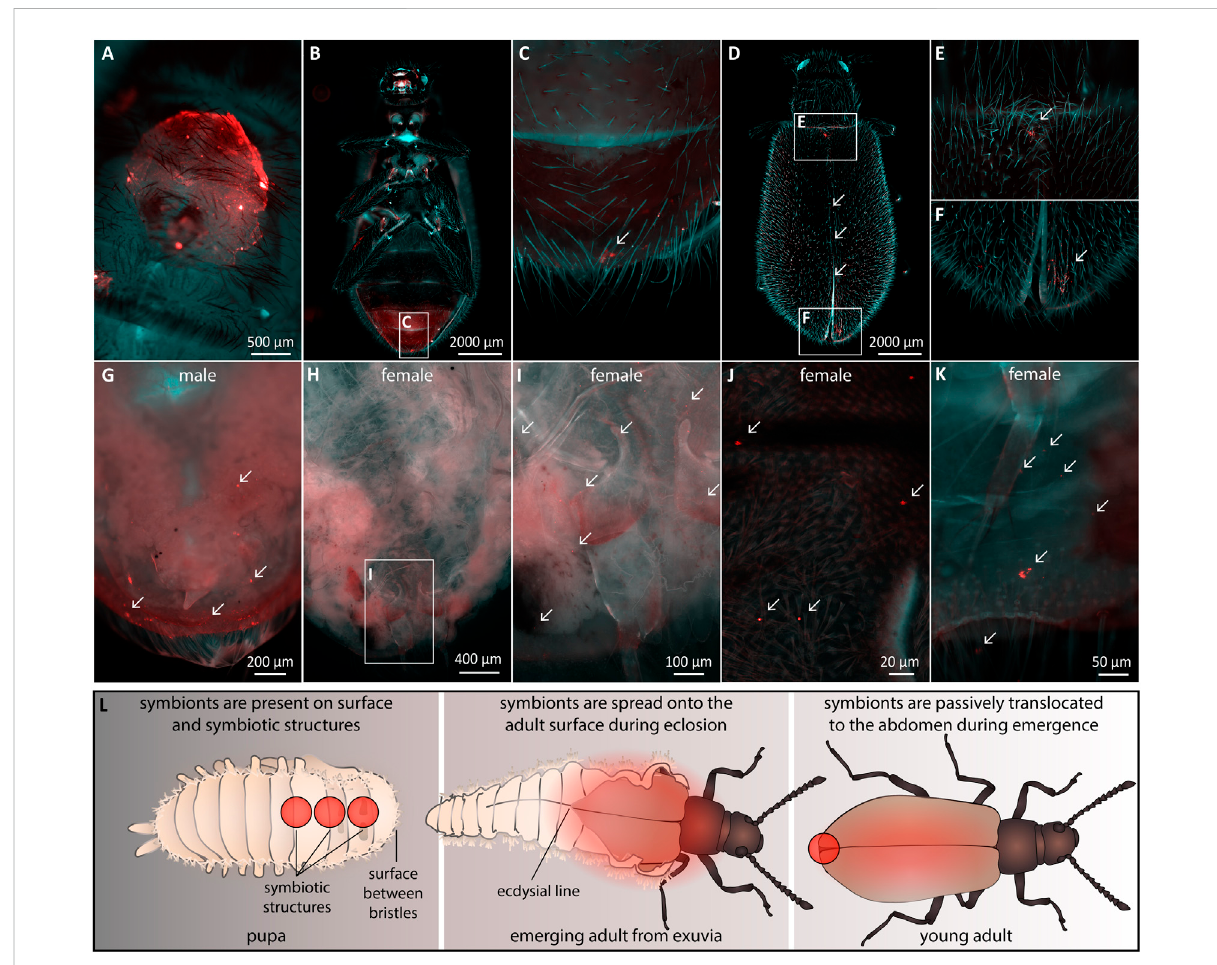
FIGURE 6 Transmissionofimmotilebeadsfromthedorsalthoraxofpupaetotheabdominalregioninadults.Fluorescentbeadswereappliedtotheregion ofthedorsalsymbiontorganin L.villosa pupaeandtheirlocationwasexaminedonemergedadults.Fluorescentbeads(arrows)areshowninred.The general auto fl uorescence of the insects in the EGFP channel is shown in cyan, while weak auto fl uorescence was also present in red. (A) Location of the applied beads on the surface of a pupa. (B) Ventral view of an emerged adult showing beads in the caudal abdominal region (C) . (D) Dorsal view of an adult showing beads on the thorax and abdomen (E) and at the caudal part on the elytra (F) . (G) Dorsal view of a male abdomen, where elytra and integument were removed showing accumulations of beads. (H – J) Dorsal view of one female abdomen without elytra and integument, showingmultiplebeadsintheregionofthereproductivesystem. (K) Dissectedabdomenofasecondfemaleshowingseveralbeadsintheabdomen. (L) Proposed mechanism of the translocation of beads and symbionts during eclosion. Red circles or areas indicate the presence of symbionts or fl uorescent beads observed across our